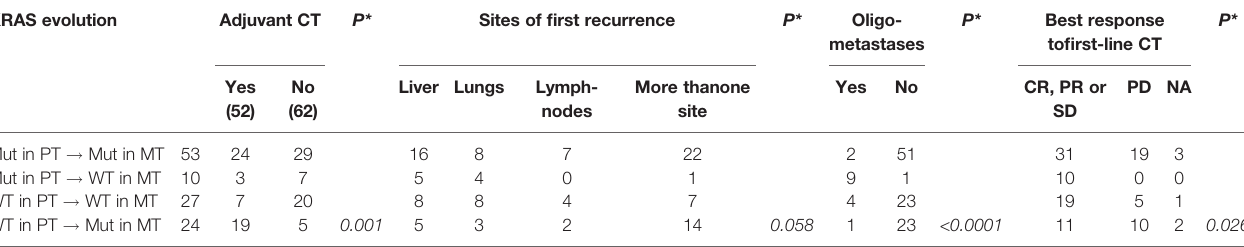
TABLE 3 | Tumor burden, adjuvant chemotherapy and response to fi rst-line CT according to KRAS evolution. KRAS evolution